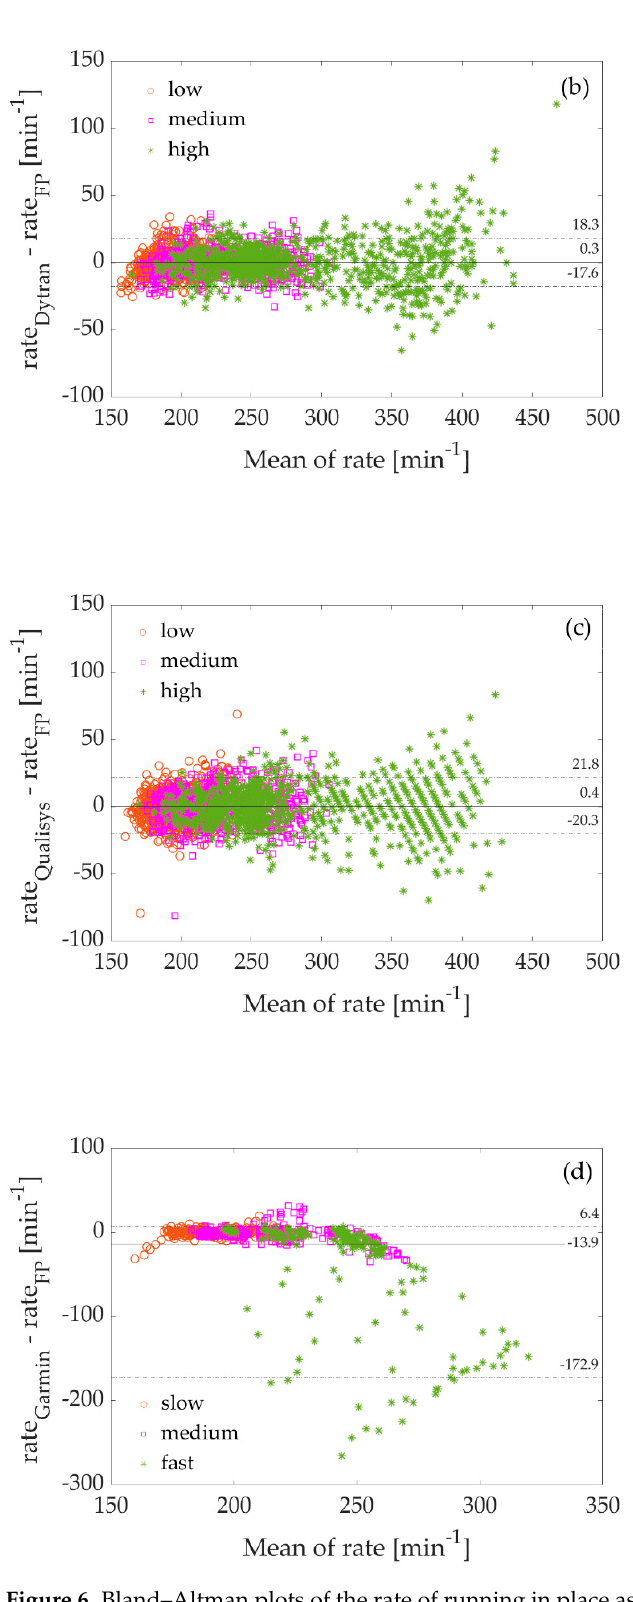
Figure 6. Bland–Altman plots of the rate of running in place as measured with ( a ) the smart patch versus force plates, ( b ) Dytran accelerometers versus force plates, ( c ) the Qualisys motion capture system versus force plates, and ( d ) the Garmin Running Pod versus S2P bilateral force plates (FP). Orange circles = slow running in place; pink squares = medium; green stars = fast. The dashed lines represent the limits of agreement (LoA), while the solid lines depict bias.